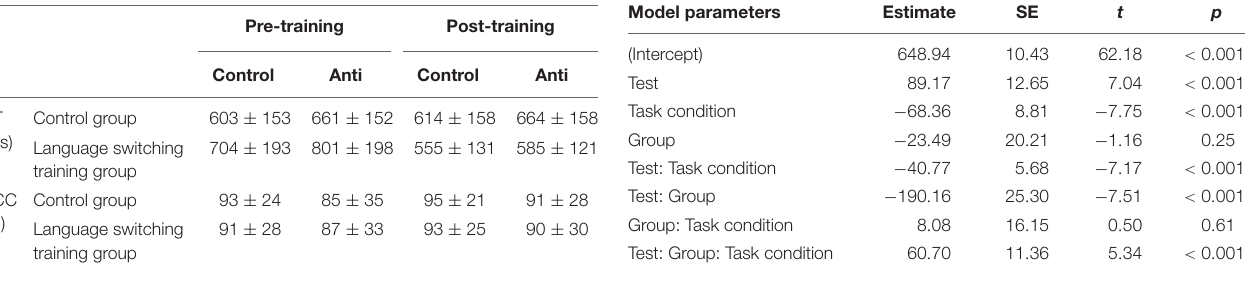
TABLE 4 | Mean RTs (and SDs) and mean accuracy (and SDs) of the anti-saccade task in Experiment 1. Pre-training Post-training Control Anti Control Anti